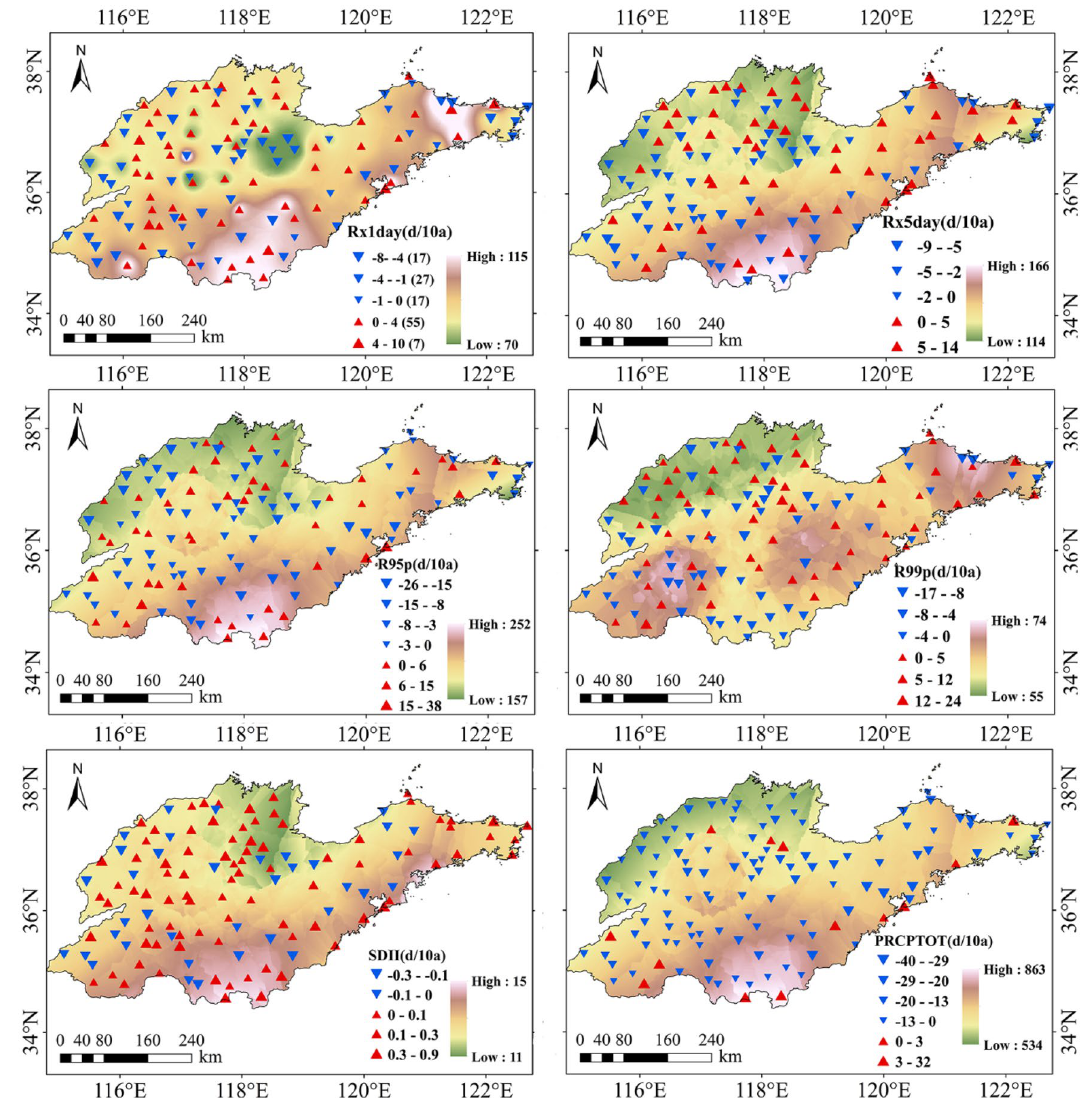
Figure 4. Temporal distribution of indices related to the number of precipitation days in Shandong from 1961 to